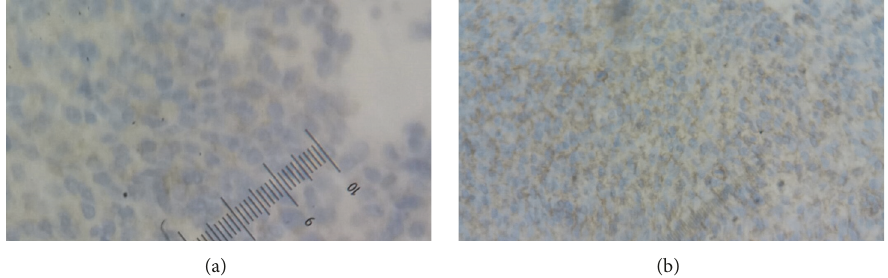
Figure 4: On immunohistochemical study, tumor cells were positive for EMA (a) and CD 99 (b).